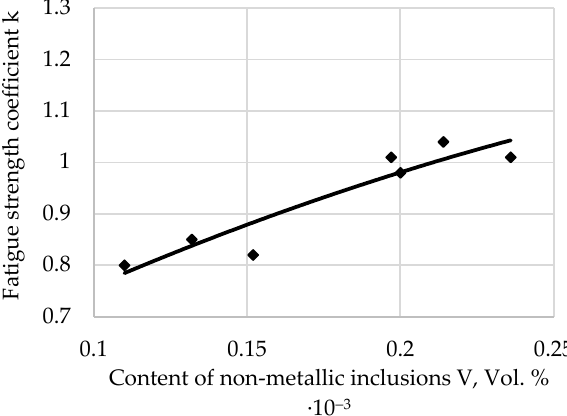
Figure 5. The bending fatigue strength coefficient, k, of research steel after hardening and tempering at 500 °C depends on the relative content of non-metallic inclusions.